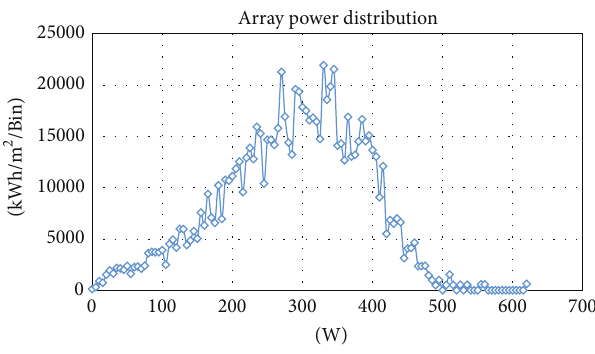
Figure 10: Array power